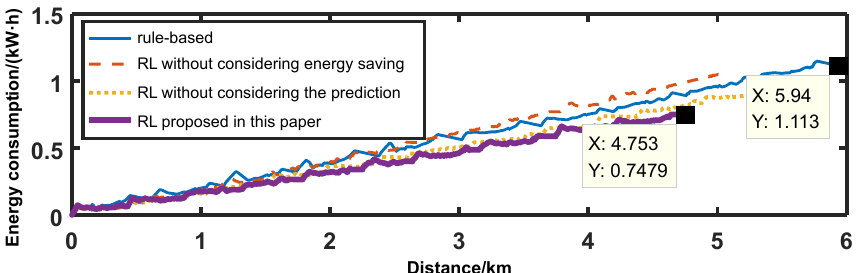
Figure 16. The comparison of vehicle energy consumption for different